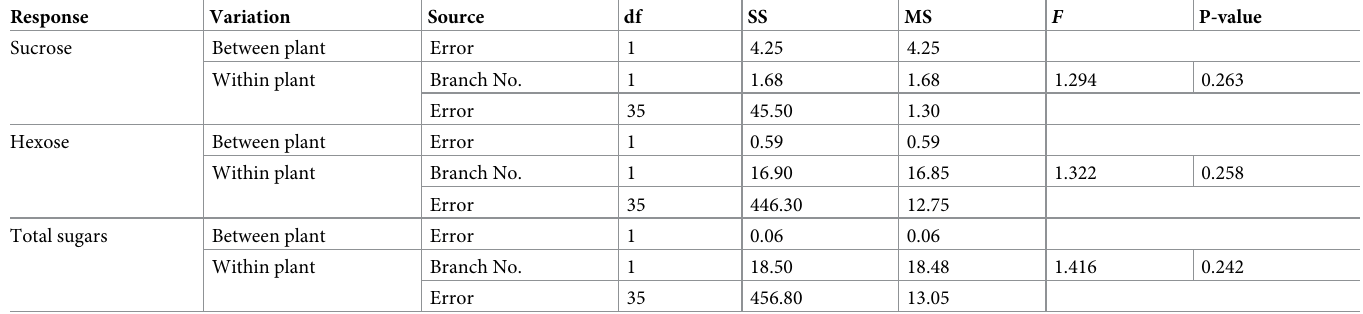
Table 2. Analysis of variance table: Repeated measures ANOVA test for first-position flowers on neighboring branches. Bracteal EF nectar of non-treated G . hirsu- tum control plants was sampled in the absence of herbivory to determine if differences existed between the flowers on neighboring branches (Branch No.). Response Variation Source df SS MS P-value Sucrose Between plant Within plant Hexose Between plant Within